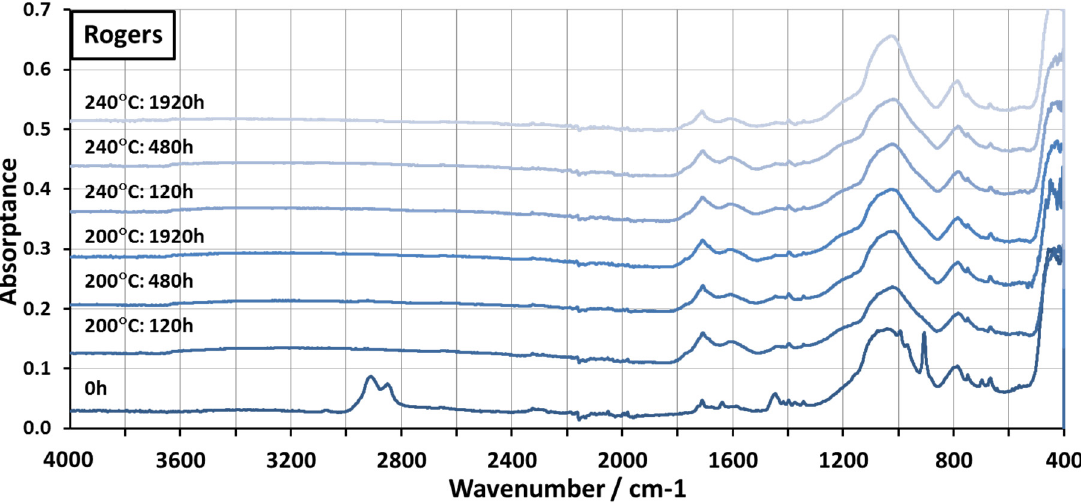
Figure 3. FTIR spectra of the Rogers PCB aged at 200 °C and 240 °C.